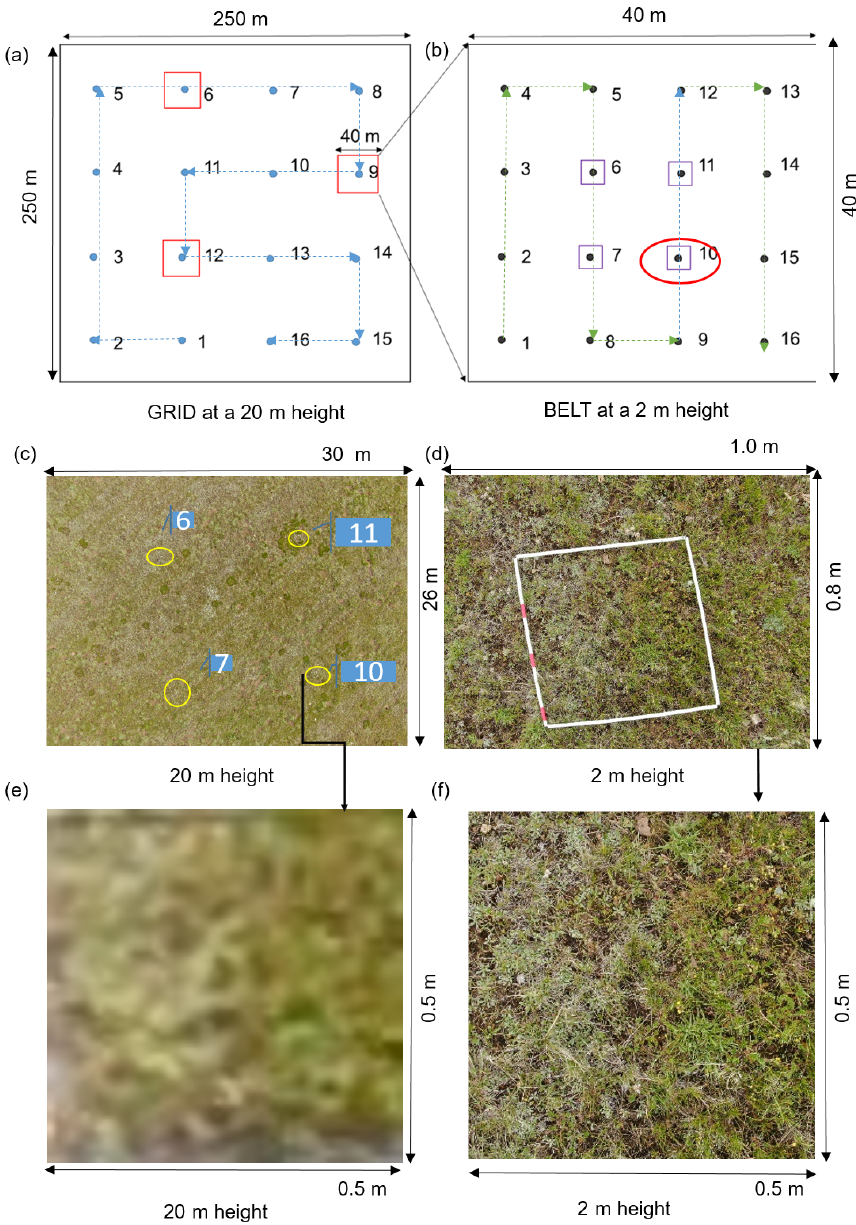
Figure 3. Schematic diagram of the UAV field synchronization experiment in 2019. A combination design of GRID (a) and BELT (b) flight modes. A UAV photo with a quadrat from the BELT mode at the height of 2m (d) . A 20m high UAV photo including four sample quadrats (c) . The cropped UAV photos at the quadrat scale from 20m (e) and 2m (f) height, respectively.